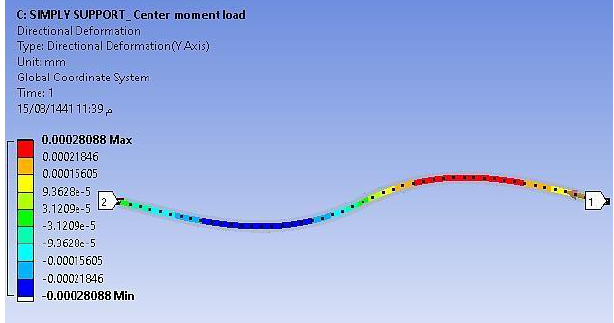
Fig. 13. Direction deformation (0.00028088 mm) of cemented carbide, simply supported centre moment load of 100